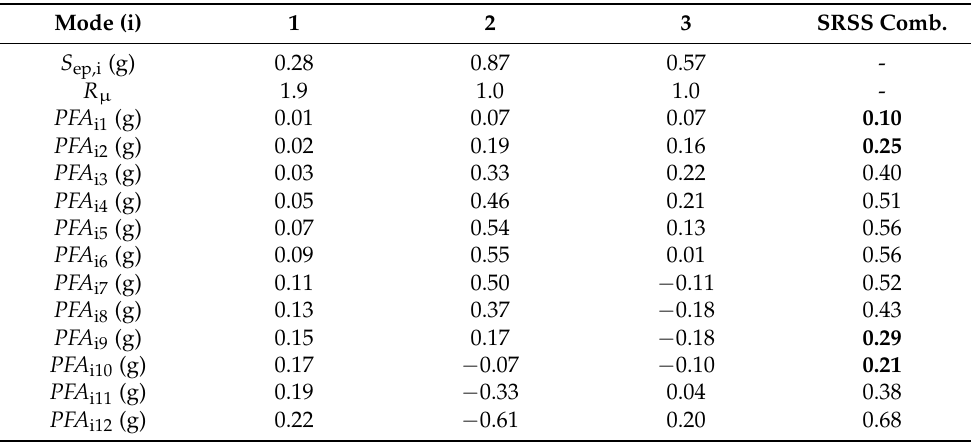
Table 3. Values in the elastic acceleration spectrum ( S ep,i ), reduction factors ( R µ ) for each mode, and individual and combined values of peak floor accelerations (PFAs) at each floor.